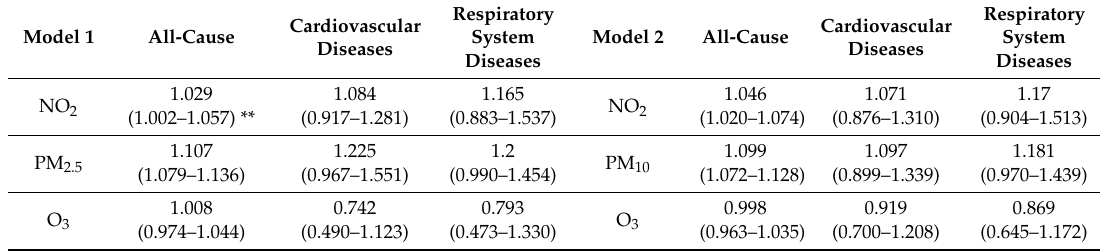
Table 3. Long-term risk for hospital admissions ( ≥ 2 days) in 2012 associated with air pollution. * exposure in 1999–2000 in the French ESPS